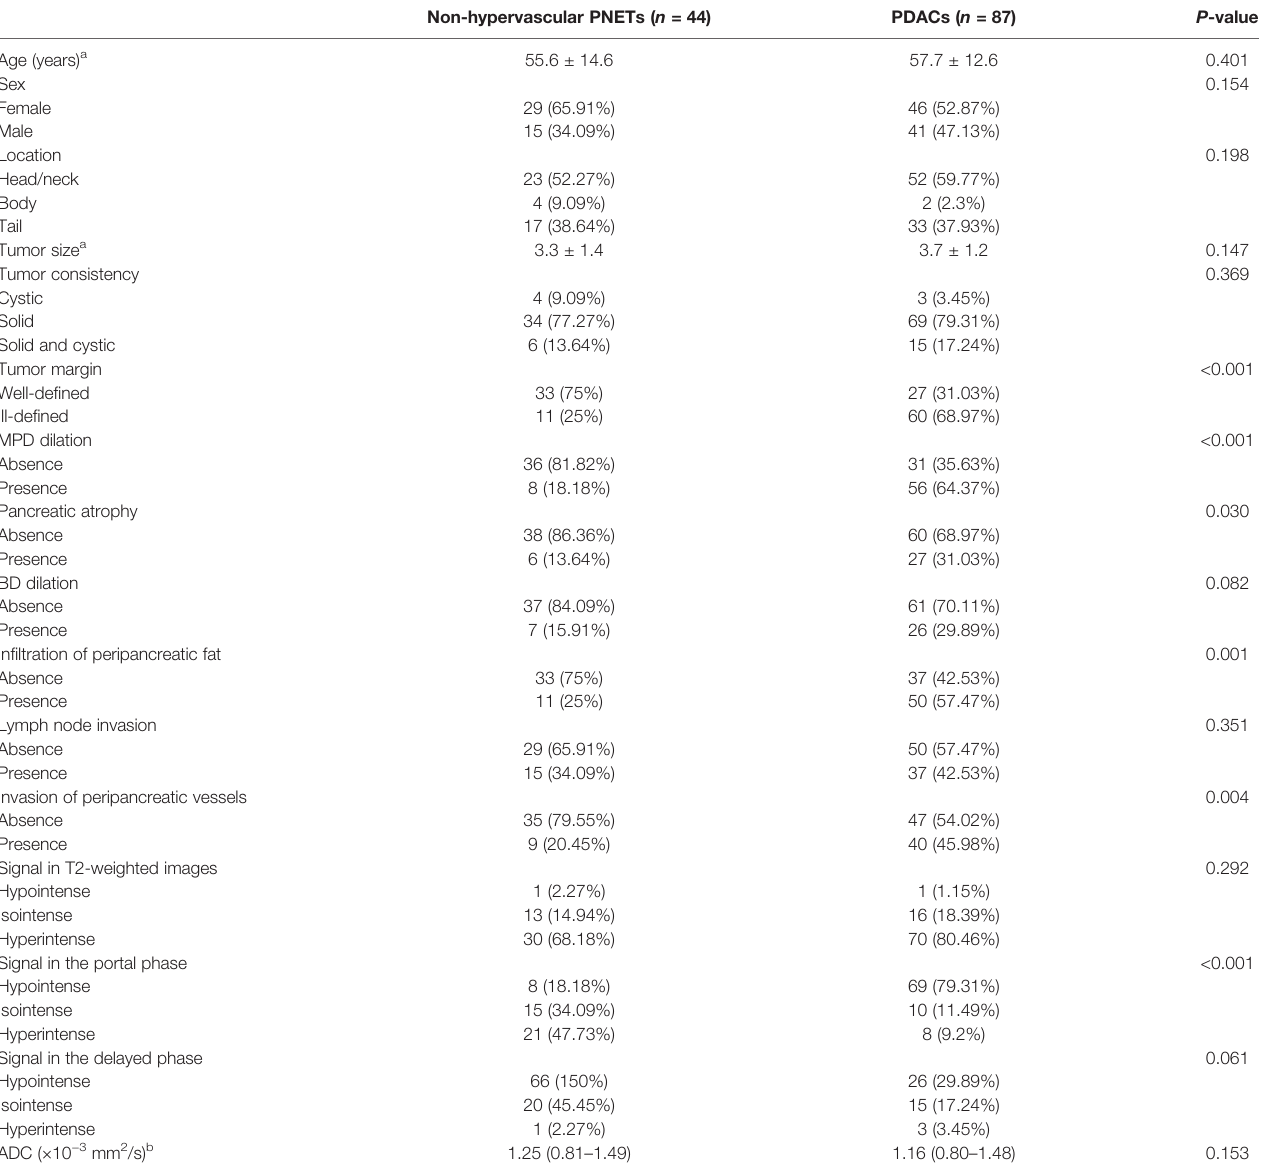
TABLE 2 | Clinical and radiological